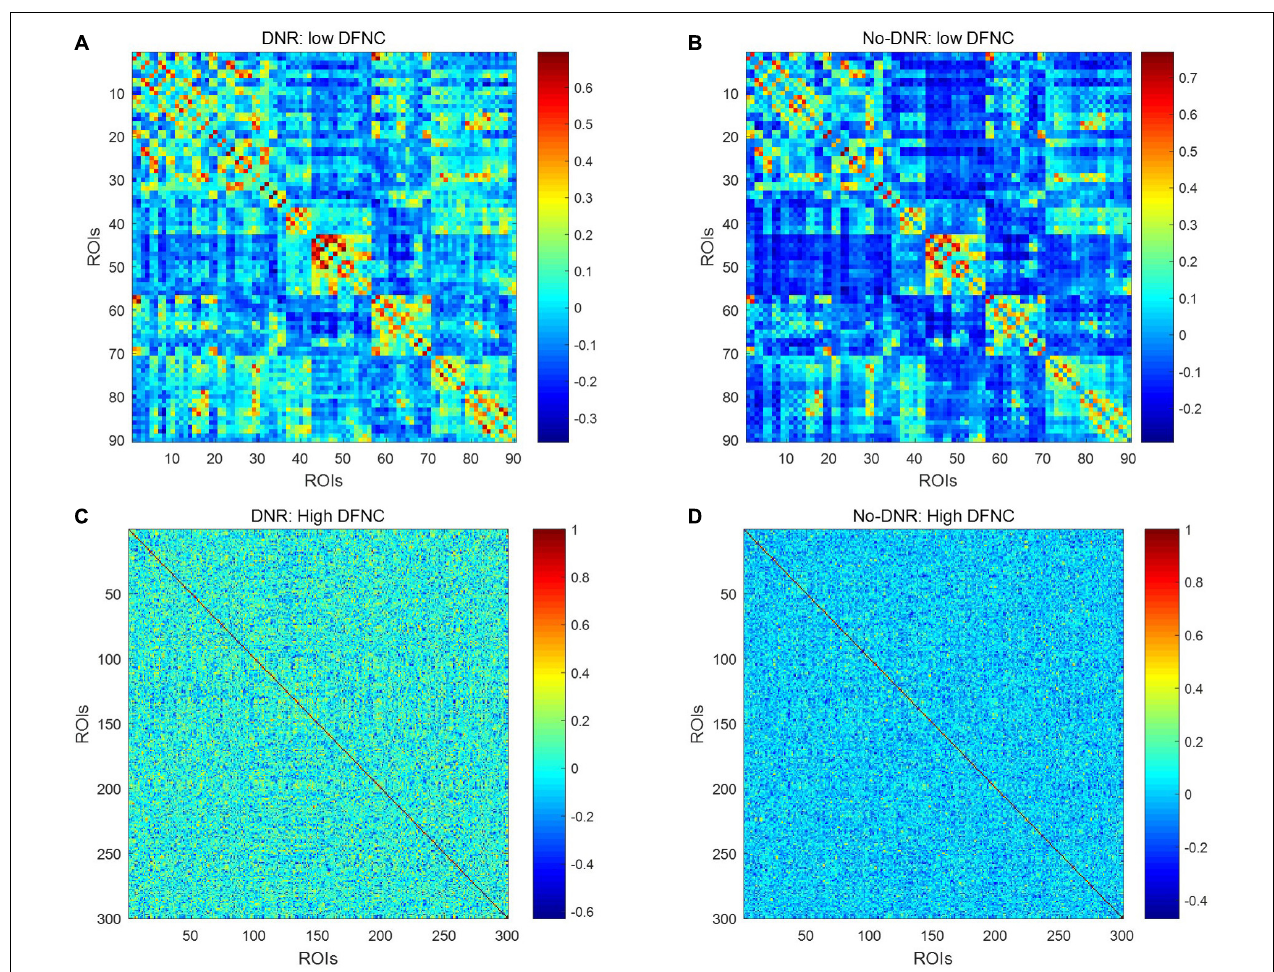
FIGURE 3 | Averaged low\high-order FC networks for all patients. Panels (A–D) are the low-order FC network of DNR, the low-order FC network of No-DNR, the high-order FC network of DNR, and the high-order FC network of No-DNR, respectively. For panels (A,B) , each element in the matrix is the correlation between two brain regions. For panels (C,D) , each element in the matrix is the correlation between two clusters. Element with light color indicates positive correlation, while the dark color shows a competitive or